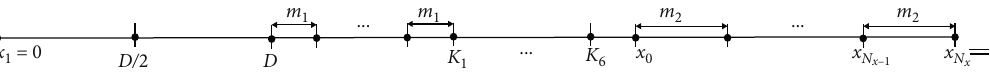
Figure 12: Nonuniform mesh for the three-asset